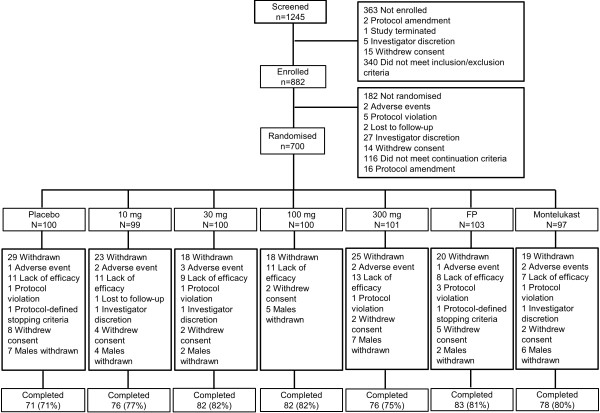
CONSORT diagram. Subject flow through study. FP = fluticasone propionate.